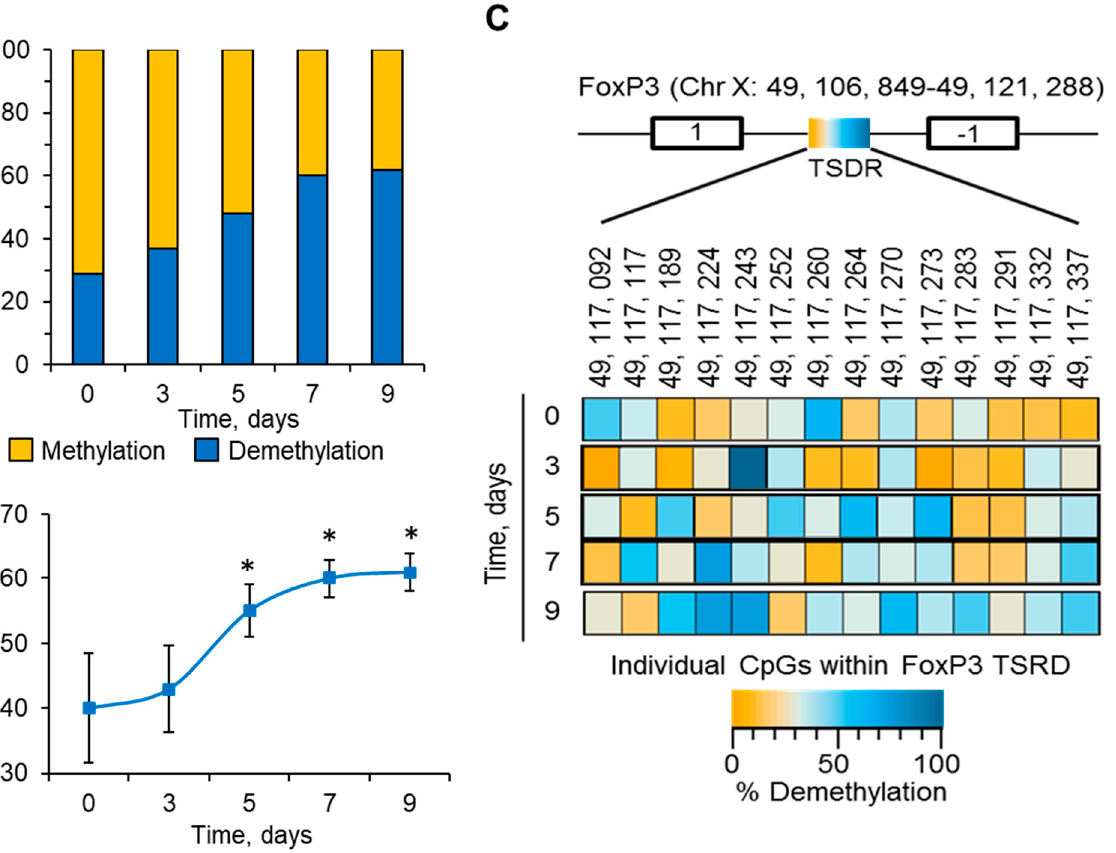
Figure 3. The level of TSDR demethylation increases during ex vivo expansion of Tregs. TSDR methylation analysis was performed during the time of cell expansion: ( A ) Levels of TSDR methylation and demethylation during Treg ex vivo maturation. ( B ) Mean level of TSDR methylation during Treg expansion. ( C ) Representative result of demethylation percentage of each CpG site in the TSDR color-coded according to the legend. Each column corresponds to a single CpG site. Absolute coordinates according to the GRCh37/hg19 human genome assembly are indicated. n = 5. * p ≤ 0.05 vs. initial cells at the 0-day time-point.